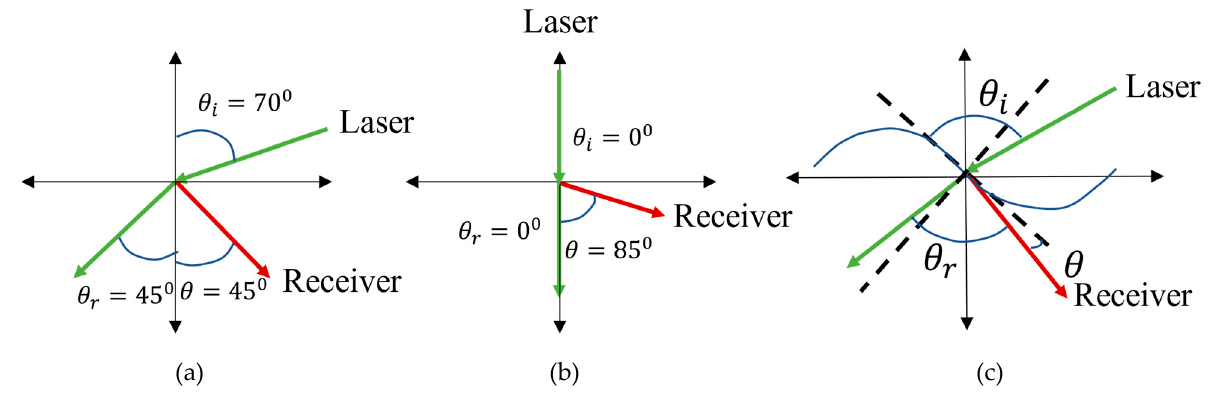
Figure 9. Optimum position of laser beam incident angle and receiver observation angle for flat water surface, ( a , b ) and wavy water surface ( c ). The figure has been redrawn from [67].